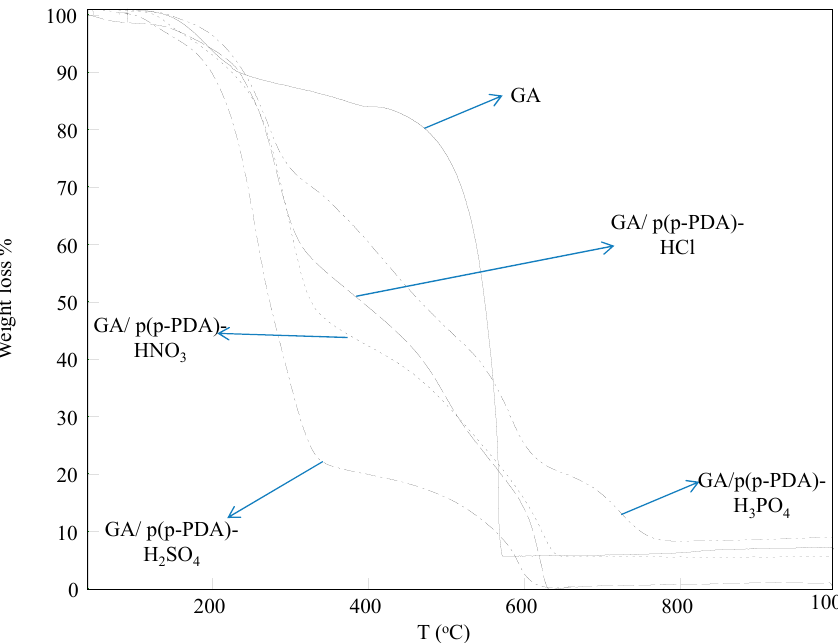
Figure 4. Thermal gravimetric (TG) thermograms of GA / p(p-PDA) composites doped with various types of acids.